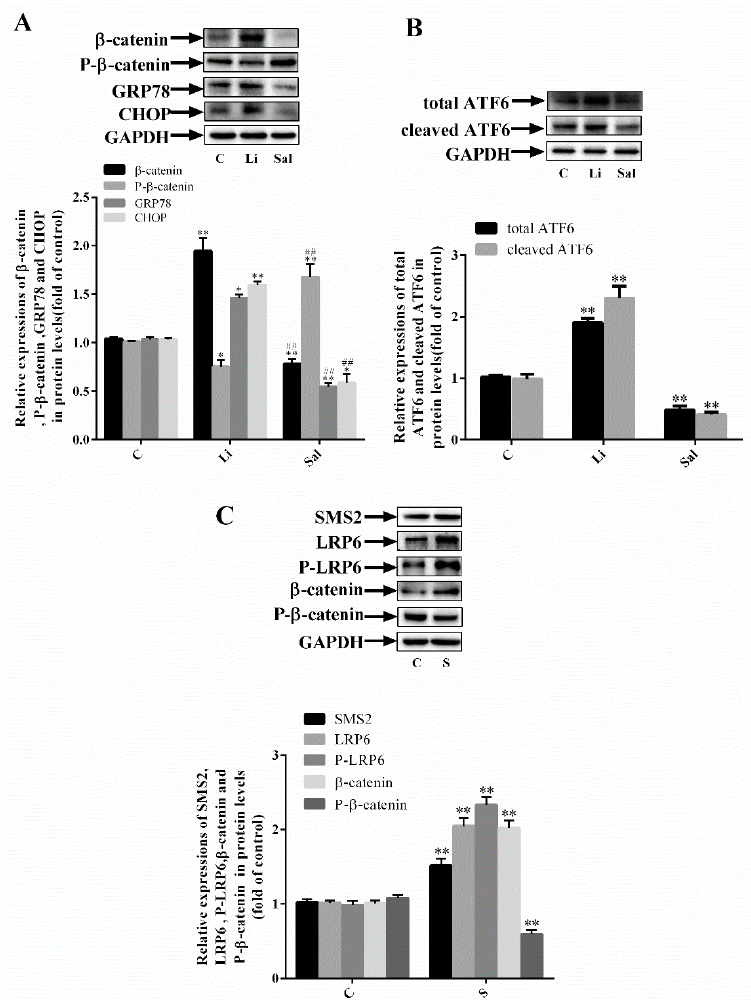
Figure 2. SMS2 can trigger ER stress by inducing the Wnt / β -catenin pathway. ( A ) Western blot analysis detected the protein expression of β -catenin, phosphorylated β -catenin, GRP78, and CHOP. ( B ) Western blotting analysis detected the protein expression of the total ATF6 and cleaved ATF6. ( C ) Western blotting analysis detected the protein expression of SMS2, β -catenin, phosphorylated β -catenin, lipoprotein receptor-related protein 6 (LRP6), and phosphorylated LRP6. n = 3, * p < 0.05 and ** p < 0.001 vs. the C group; ## p < 0.001 vs. the Li group. C, control cells; S, cells overexpressing SMS2; Li, LiCl group, control cells treated with LiCl (40 µ mol / L) for 24 h; Sal, salinomycin group, control cells treated with salinomycin (5 µ mol / L) for 24